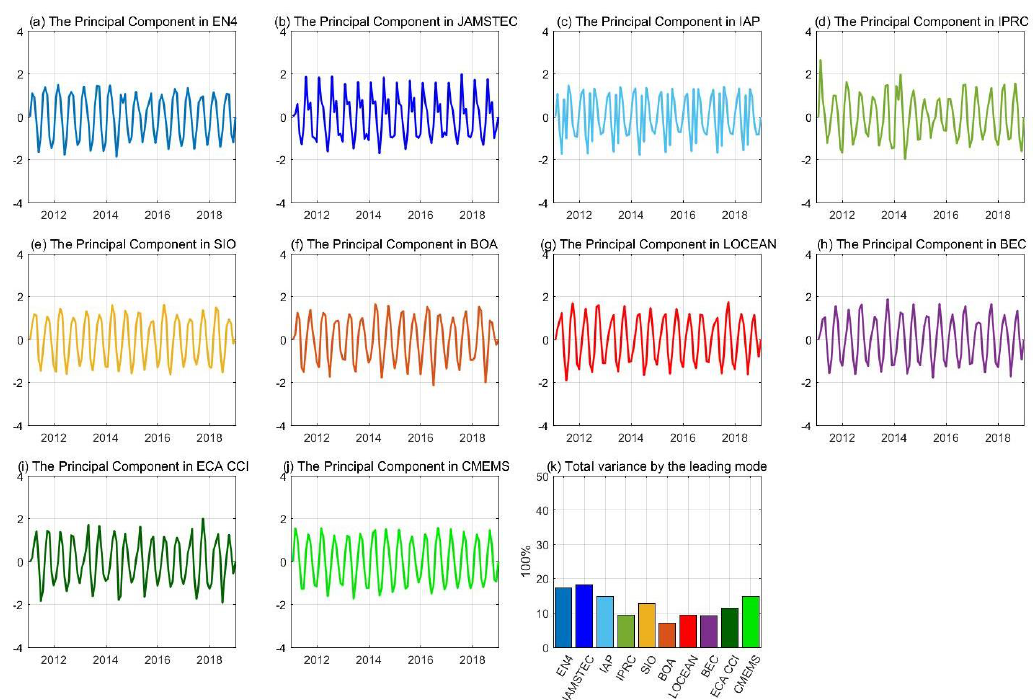
Figure 6. ( a – j ) The principal components for sub-annual SSS time series and ( k ) their contributions to the total variability in the sub-annual SSS signal. The dark blue line and bar in ( k ) denote EN4, blue represents JAMSTEC, light blue represents IAP, green represents IPRC, yellow represents SIO, orange represents BOA, red represents LOCEAN, purple represents BEC, dark green denotes ECA CCI and bright green denotes CMEMS.